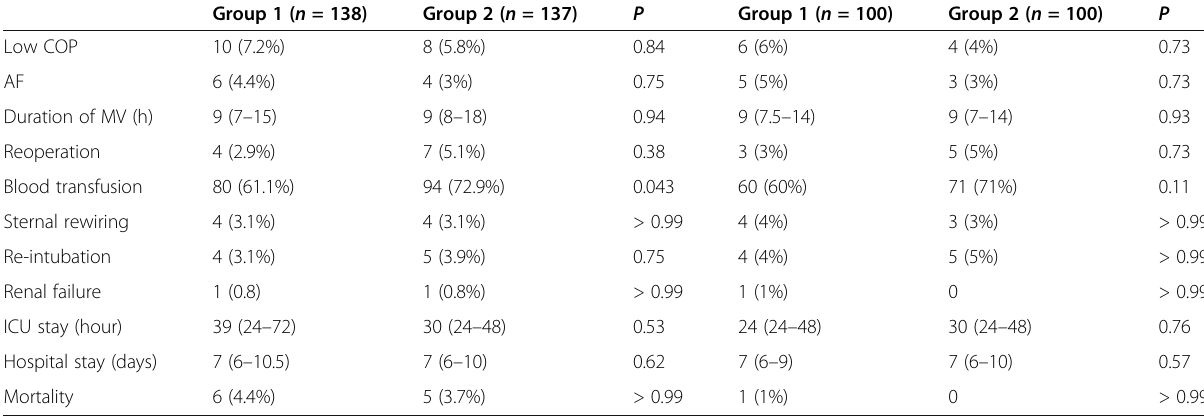
Table 3 Postoperative